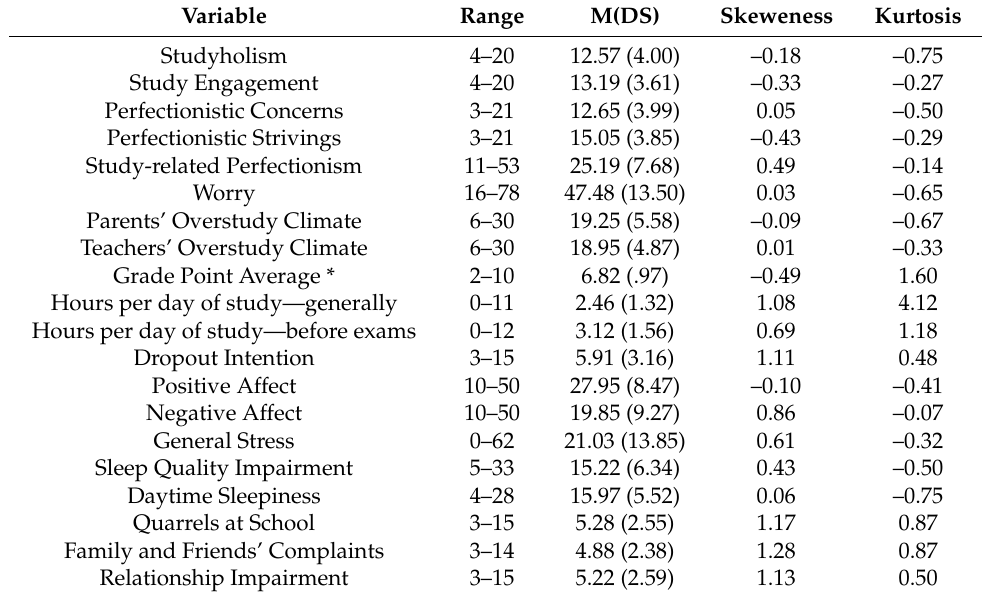
Table 1. Descriptive statistics of the variables in the model ( n =